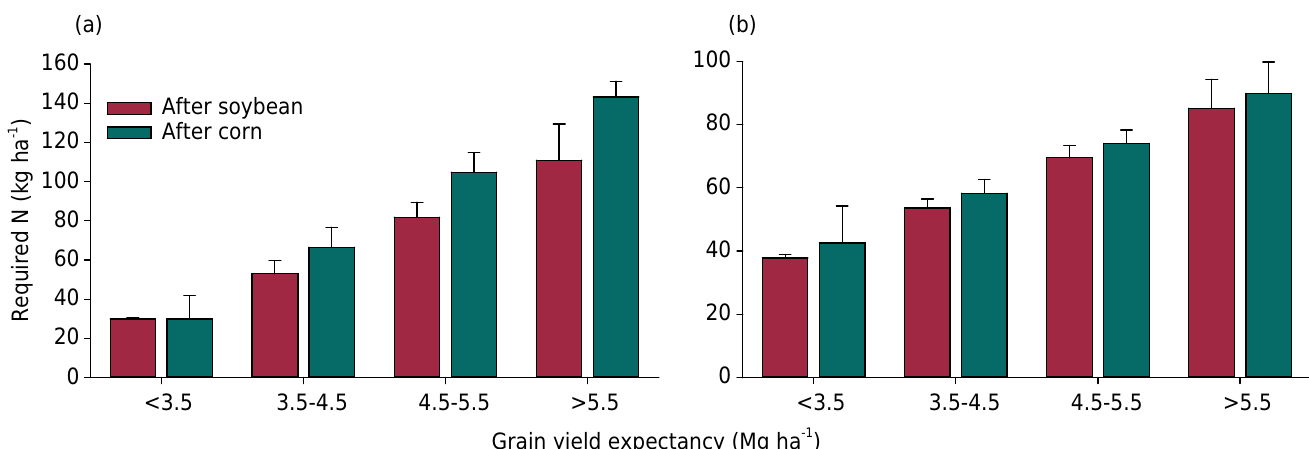
Figure 3. Expected grain yield of wheat (a) and barley (b) and urea-N rates required by the crops for a mean expected yield within the ranges 3.5-4.5 and 4.5-5.5 Mg ha -1 and yields of 3.0 and 6.0 Mg ha -1 within the expected yield ranges of <3.5 and >5.5 Mg ha -1 , respectively, when cultivated after soybean and corn. Vertical bars indicate mean standard